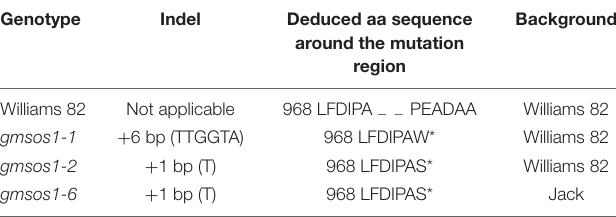
TABLE 1 | List of the gmsos1 mutants in this